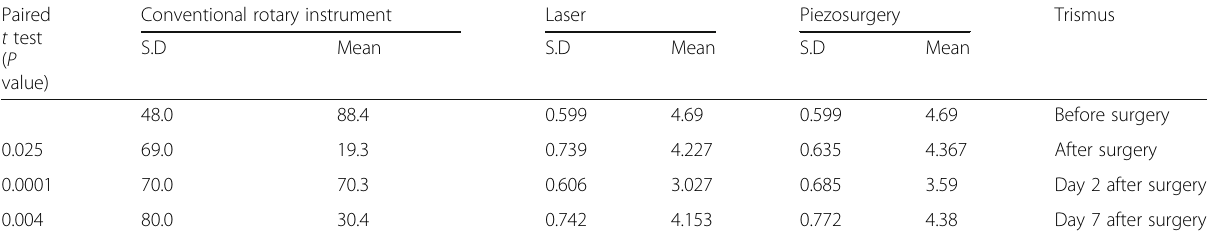
Table 3 Comparison of the amount of mouth opening to investigate trismus in the three surgical techniques Paired t test ( P value)